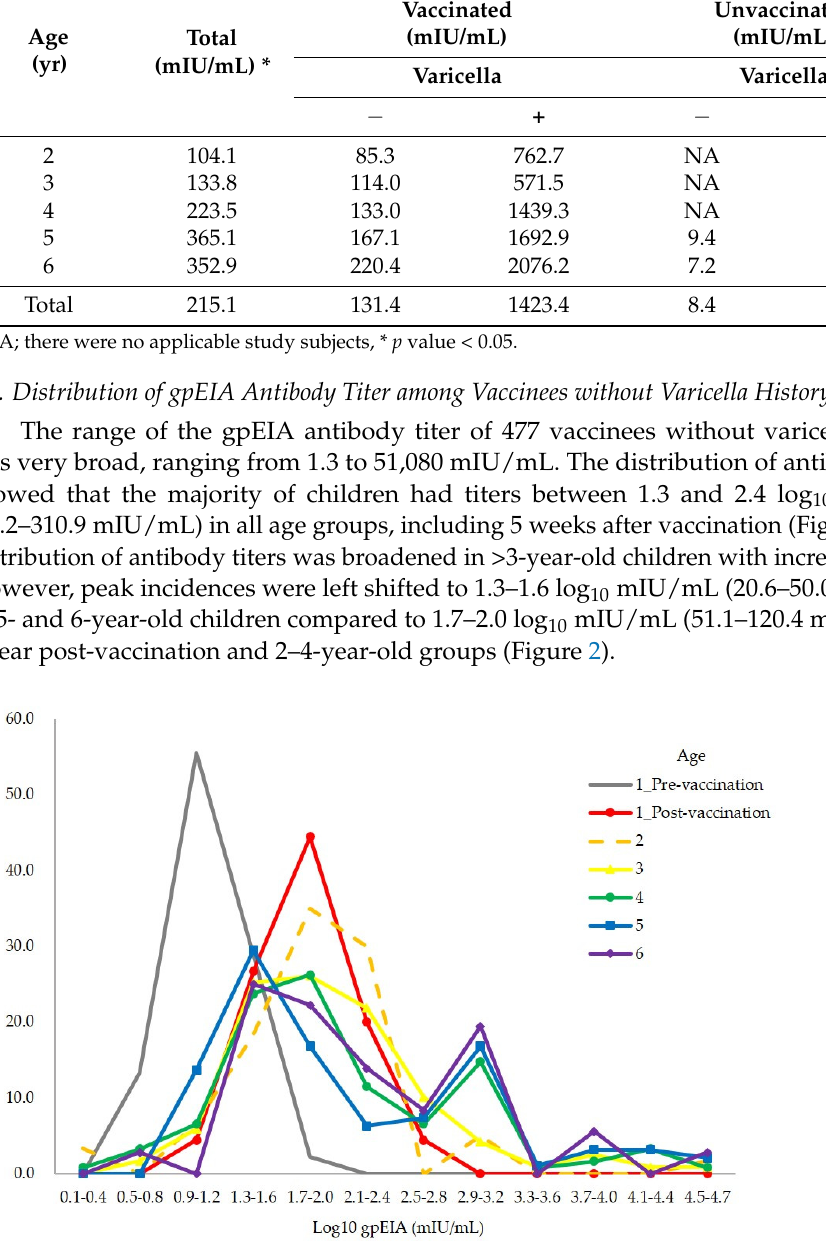
Figure 3. gpEIA titers of 109 vaccinees with varicella history according to the time elapsed from varicella disease. The p values were calculated using Kruskal–Wallis test using Tukey’s multiple comparisons test. ** p < 0.01, **** p < 0.0001. 4. Discussion In this study, 2- to 6-year-old healthy Korean children were enrolled to evaluate their varicella immune status. Since the varicella vaccine has been included in the NIP since